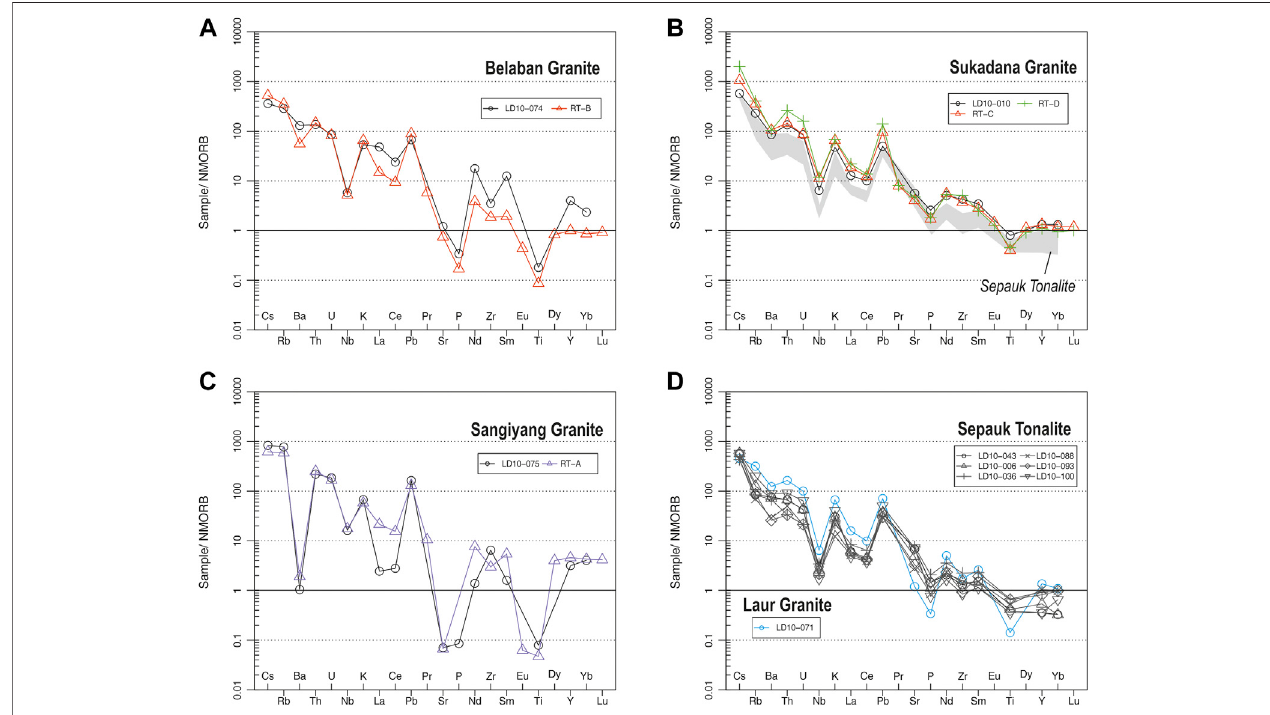
FIGURE 10 | Trace element spider diagrams for intrusive rocks of the Schwaner Mountains normalised to NMORB (Sun and McDonough, 1989). (A) Belaban Granite samples, (B) Sukadana Granite samples, (C) Sangiyang Granite samples, (D) Sepauk Tonalite samples and Laur Granite sample.